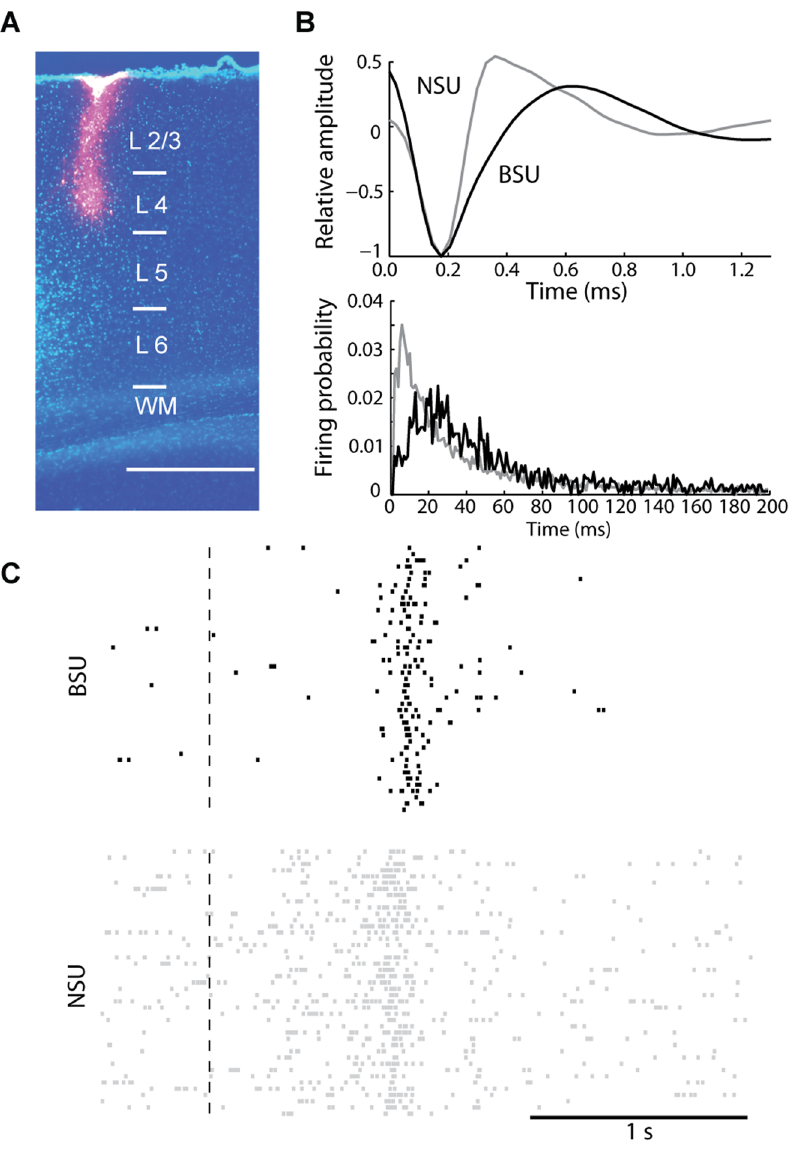
Figure 6. A BSU and a NSU isolated with spike sorting from multiunit recordings in layer 4. A . Nissl counterstained coronal section in a rat recorded with an electrode coated with DiI (red) consisting of 4 horizontally aligned tetrodes located at the tip (point of maximal penetration). Bar. 600 m m. B . Example of an extracellularly isolated BSU (black) and NSU (gray). Top plot: mean AP waveforms; bottom plot: interspike interval distributions. Both plots were obtained taking into account only APs occurring in absence of visual stimulation. Note the narrower AP shape of the NSU and that the interspike interval distribution of the NSU is skewed towards shorter values. C . Examples of raster plots recorded from a BSU (top, black) and a NSU (bottom, gray) when visual stimulation was presented. Dashed line indicates the motion onset of the light bar on the screen. Note the higher spontaneous activity for the NSU compared to the BSU. doi:10.1371/journal.pone.0082044.g006 (ISI) values were significantly shorter for NSUs compared to BSUs (Figure 7B, left; medians: 106.1 vs. 163.2 ms, respectively; Mann- Whitney Rank Sum test; p , 0.01). As expected, average sponta- neous firing rates of NSUs were higher compared to BSUs (Figure 7B, right; medians: 10.5 vs. 6.6 Hz, respectively; Mann- Whitney Rank Sum test, p , 0.01). Conversely, only a trend was found for visual responses (expressed as the difference between peak and baseline firing rates, see Materials and Methods), with NSUs responding slightly more than BSUs (medians: 18.7 vs.